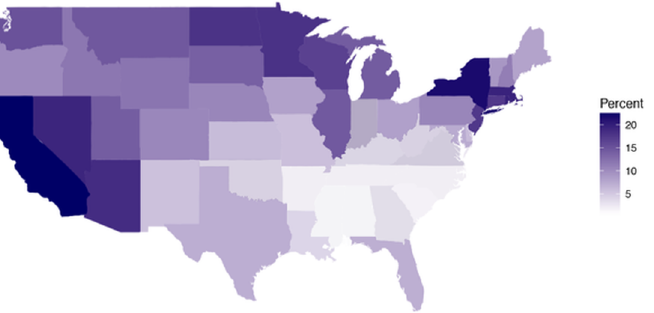
Fig 3. Average percent foreign born populations of the states of the continental United States. Based on censuses from 1850 (or between 1860 and 1890 for later-entry states) until 2010. Darker colors indicate higher percent foreign born